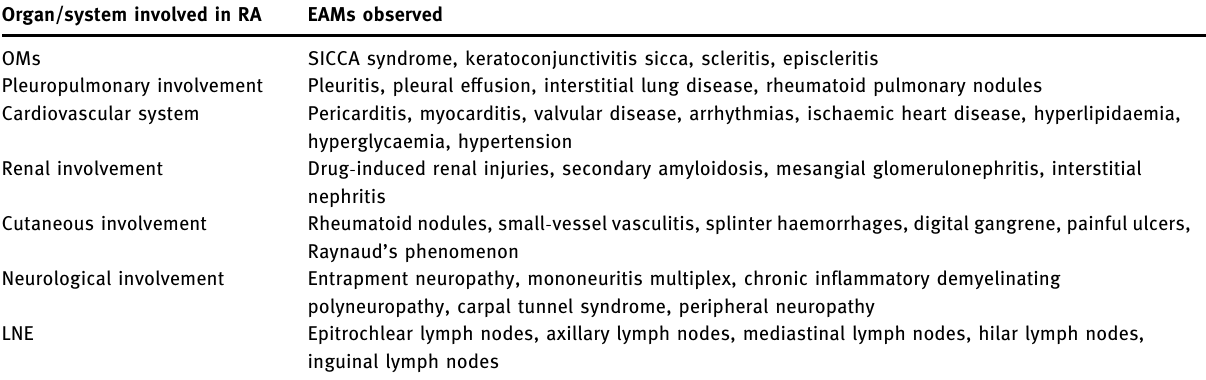
Table 1: EAMs in RA Organ/system involved in RA EAMs